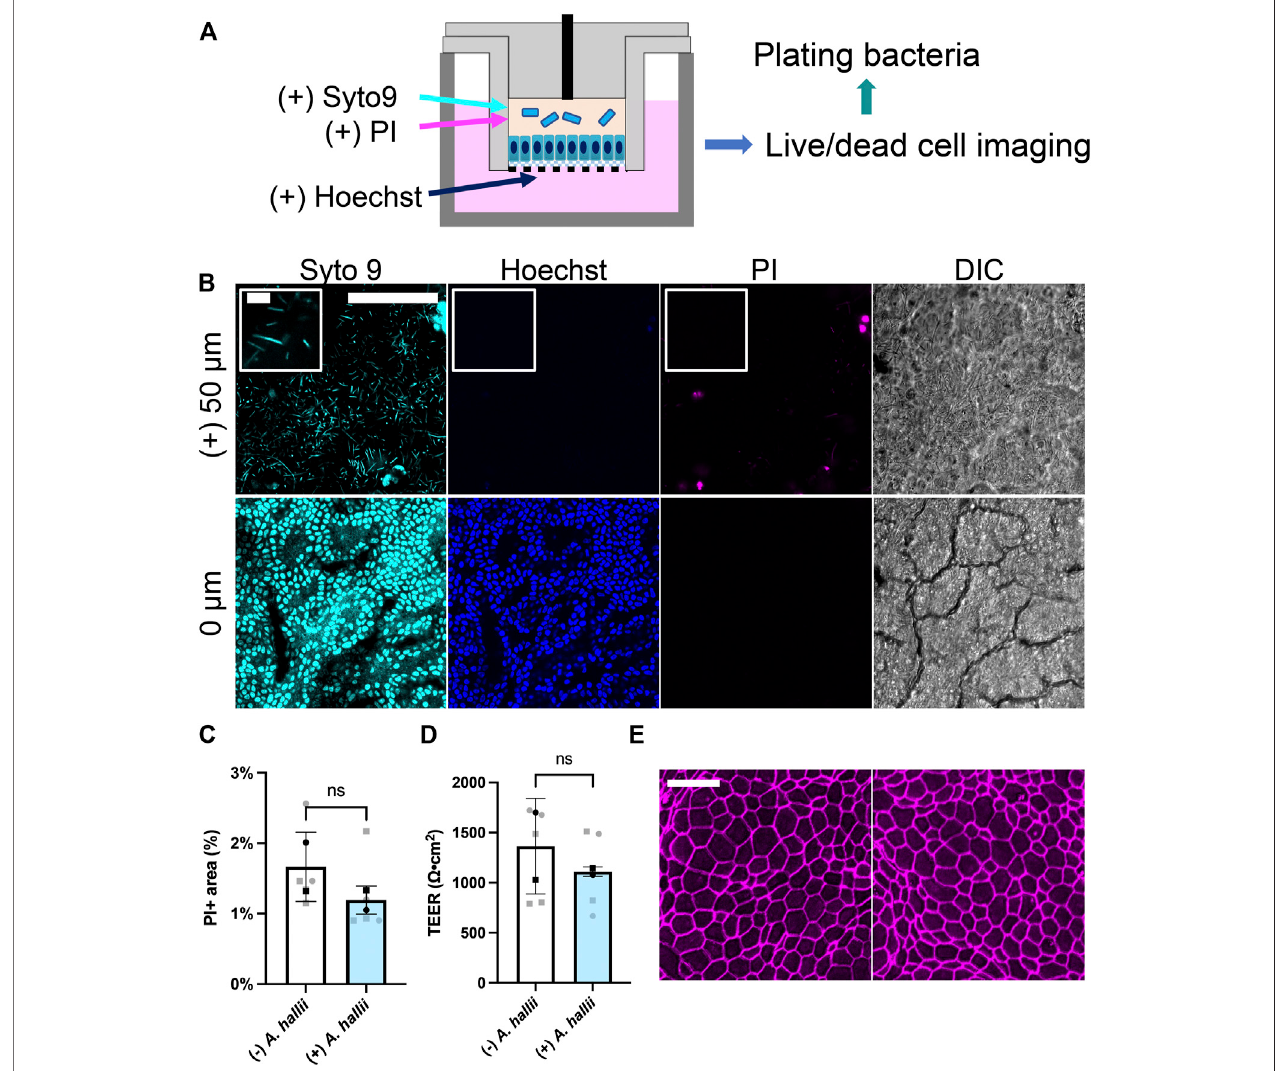
FIGURE 2 | Co-culture of A. hallii with human colon epithelial cells in the O 2 gradient cassette. (A) Schematic of the co-culture system. (B) Fluorescence confocal images were acquired after 24 h of co-culture at the plane of the colonic epithelium (0 μ m) and 50 μ m above the plane of the epithelial cell layer. Cyan: Syto 9, magenta: PI,blue:Hoechst33342.Scalebar=100 μ m(10 μ mintheinsets). (C) ShownontheYaxisistheareaoftheculturepositiveforPI fl uorescencedividedbythatpositivefor Hoechst 33342 fl uorescence and (D) measured TEER. n = 5 data points from 2 biological replicates with 3 technical replicates of donor 1- square, two technical replicatesofdonor2-circles. Blacksquaresandblackcirclesindicatetheaverageofthereplicatesfordonor1and2,respectively. Thebars representtheaverageofthe biological replicates (donor 1 and 2), and the error bars the standard deviation of the data. Paired t-test was used for the statistical analyses. (E) Confocal fl uorescence images of monolayers immunostained for ZO-1. Left: no bacterial exposure, right: A. hallii co-culture. Scale bar = 20 μ m.